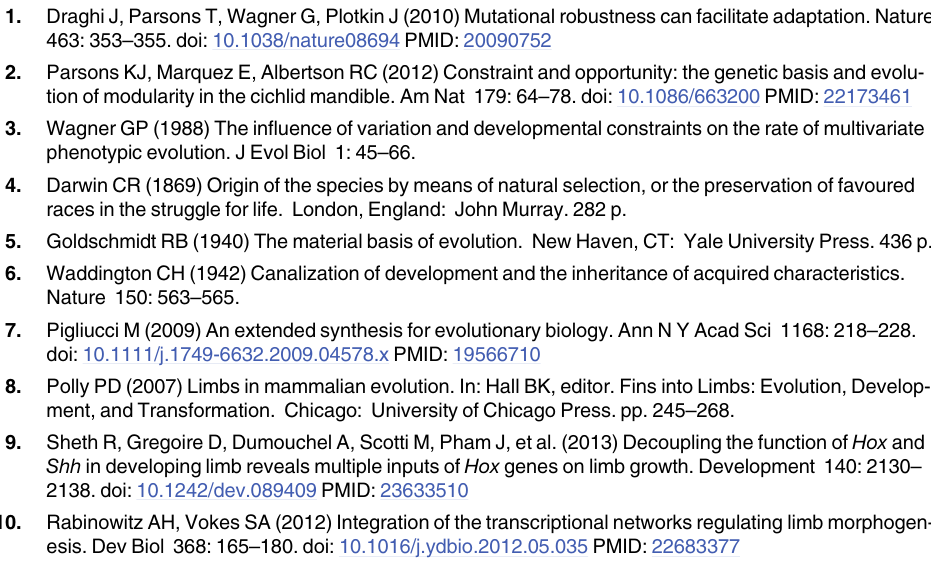
S1 Table. Full results of sensitivity analyses, including all tested parameter values and their impact on gene expression